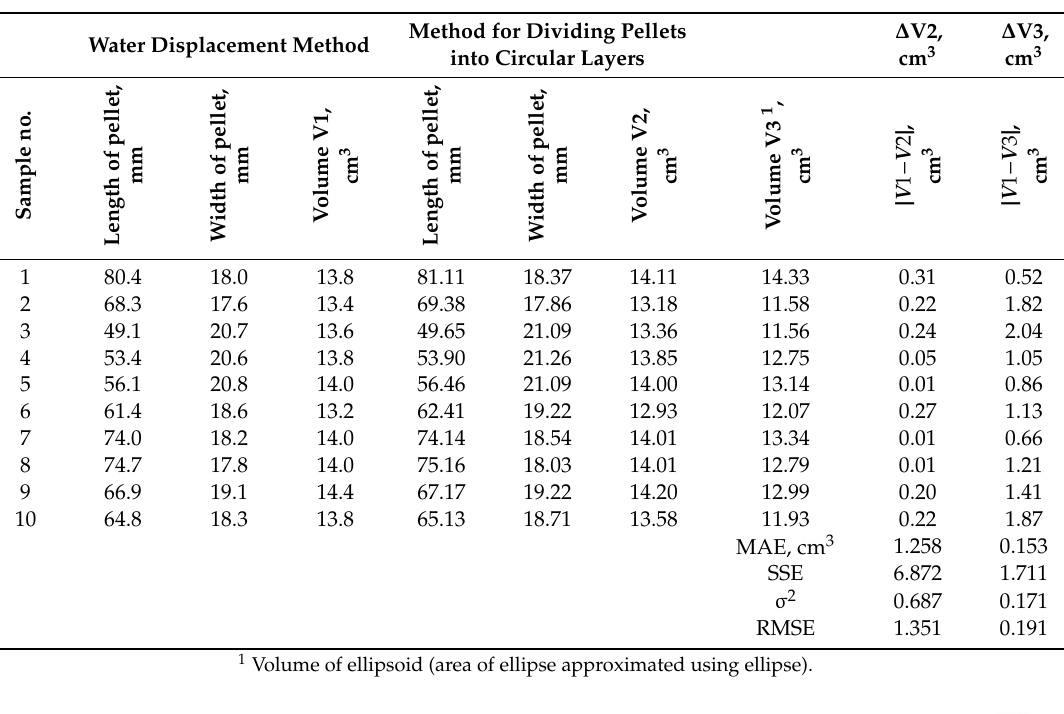
Table 1. Calculation of volume of pellet model (pellet was divided into circular layers).